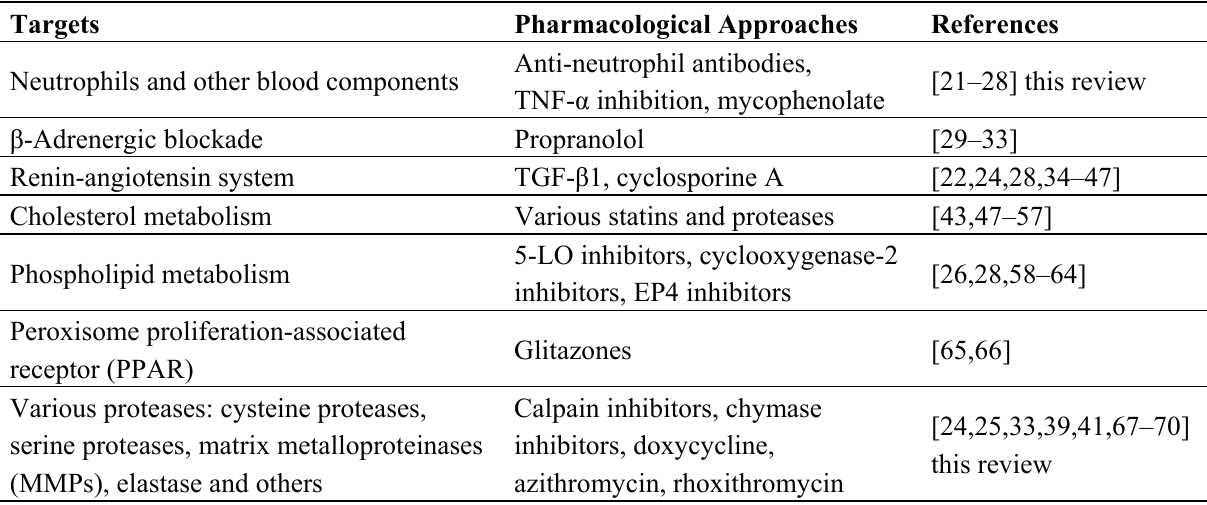
Table 1. Targets and pharmacological approaches for a conservative treatment of abdominal aortic aneurysm